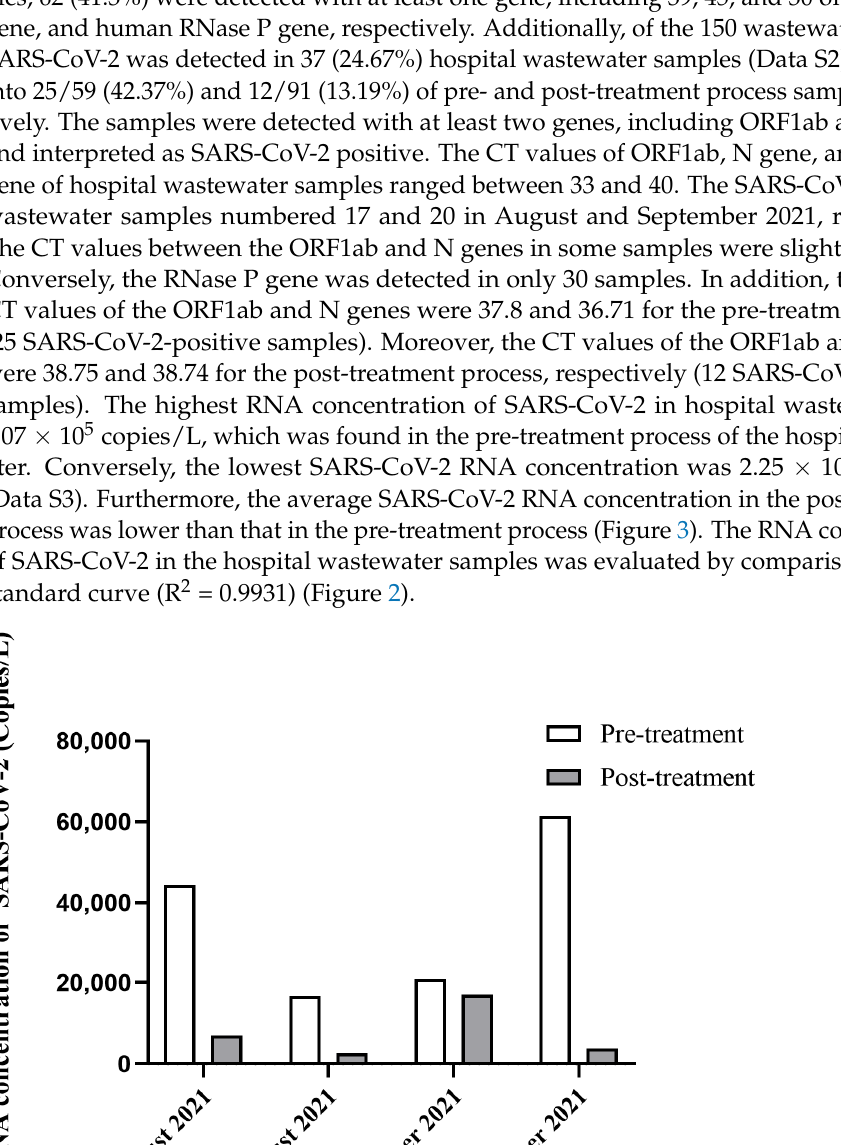
Table 3. Cost analysis for the detection of SARS-CoV-2 in hospital wastewater using an RT-qPCR assay.